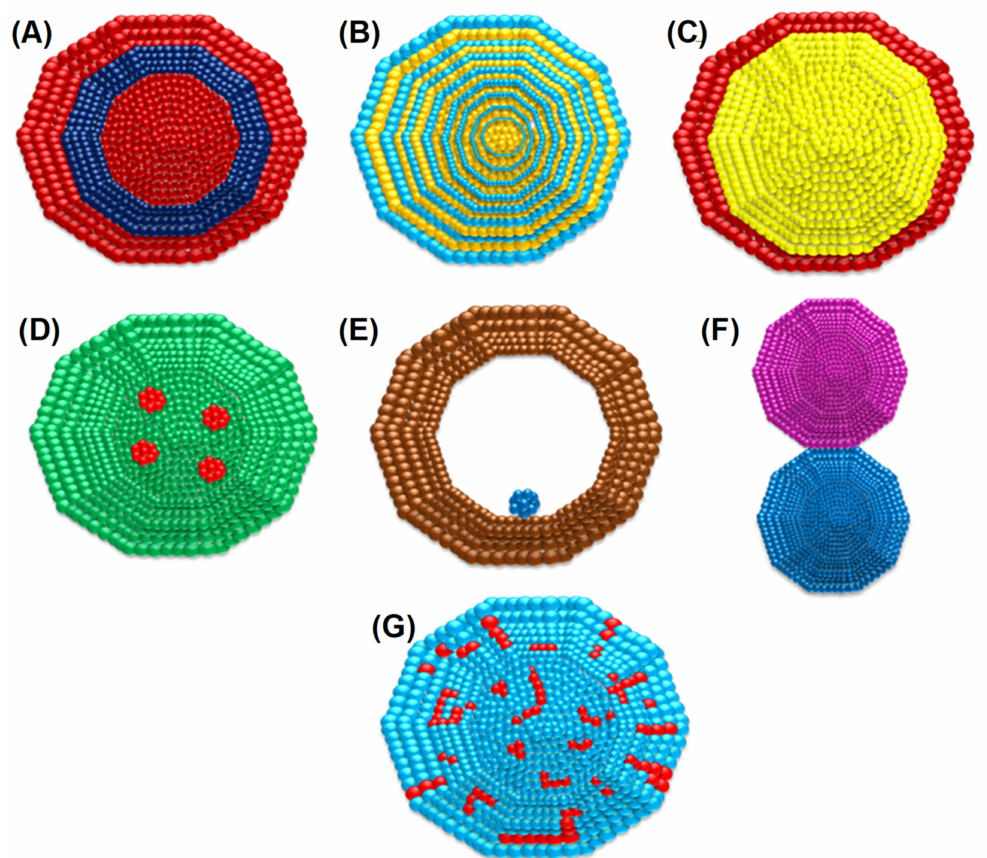
Figure 1. Various arrangements of bimetallic atoms in the nanoparticles. ( A ) Alloy, ( B ) intermetallic, ( C ) subclusters, ( D ) core–shell, ( E ) multishell core–shell, and ( F ) multiple-core materials coated by a single shell and ( G ) disordered alloy. (Different metal atoms are depicted in different